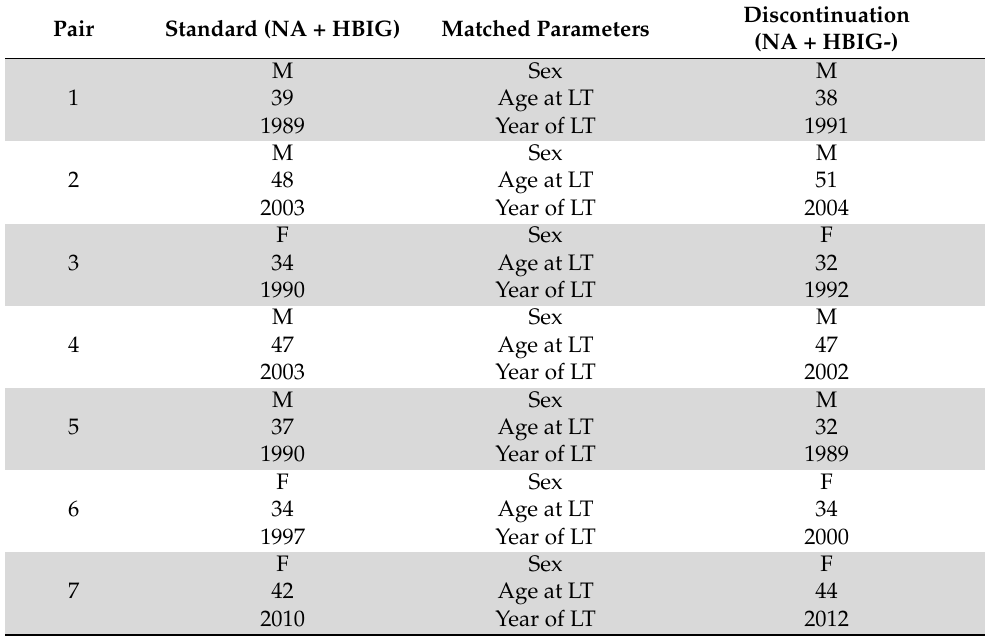
Table 2. Matched pairs used for analysis. Standard—life-long combination of HBIG with